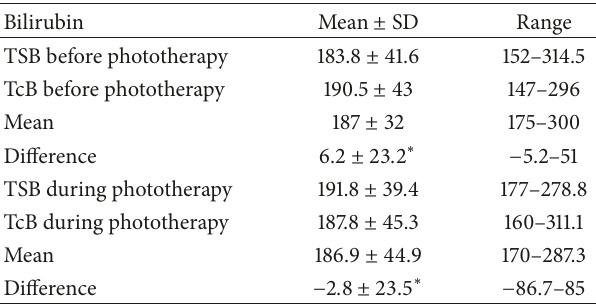
Table 1: Total serum and transcutaneous bilirubin levels before and during phototherapy in